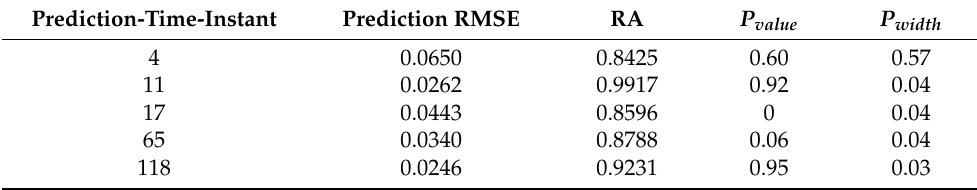
Table 11. TheRMSE,RA, P value and P width of5time-instantofinterestontests1(B0007andlinear equation).